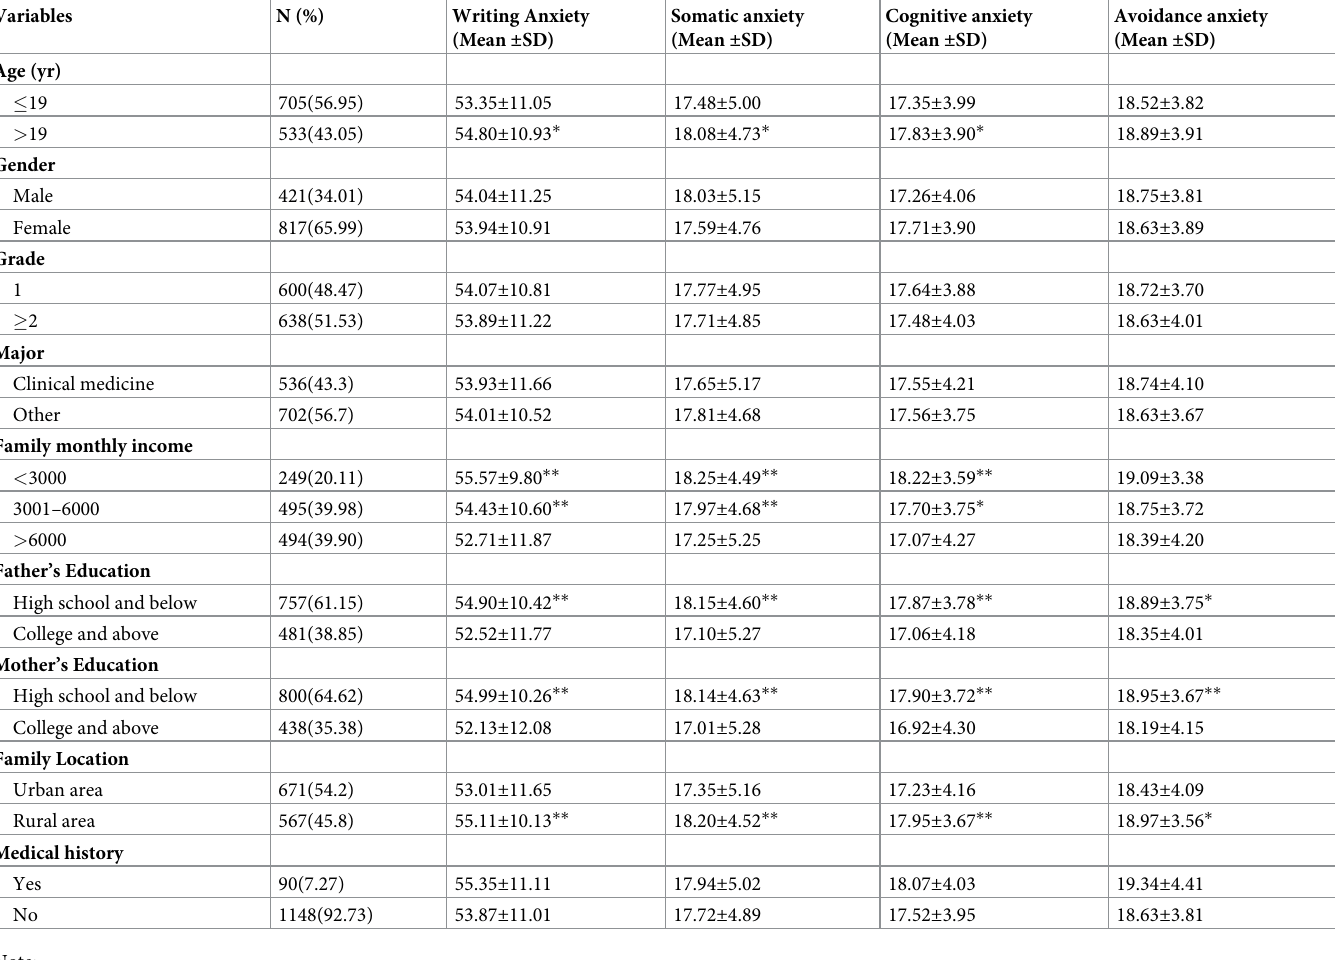
Table 1. Demographic characteristics and distributions of EFL writing anxiety among college